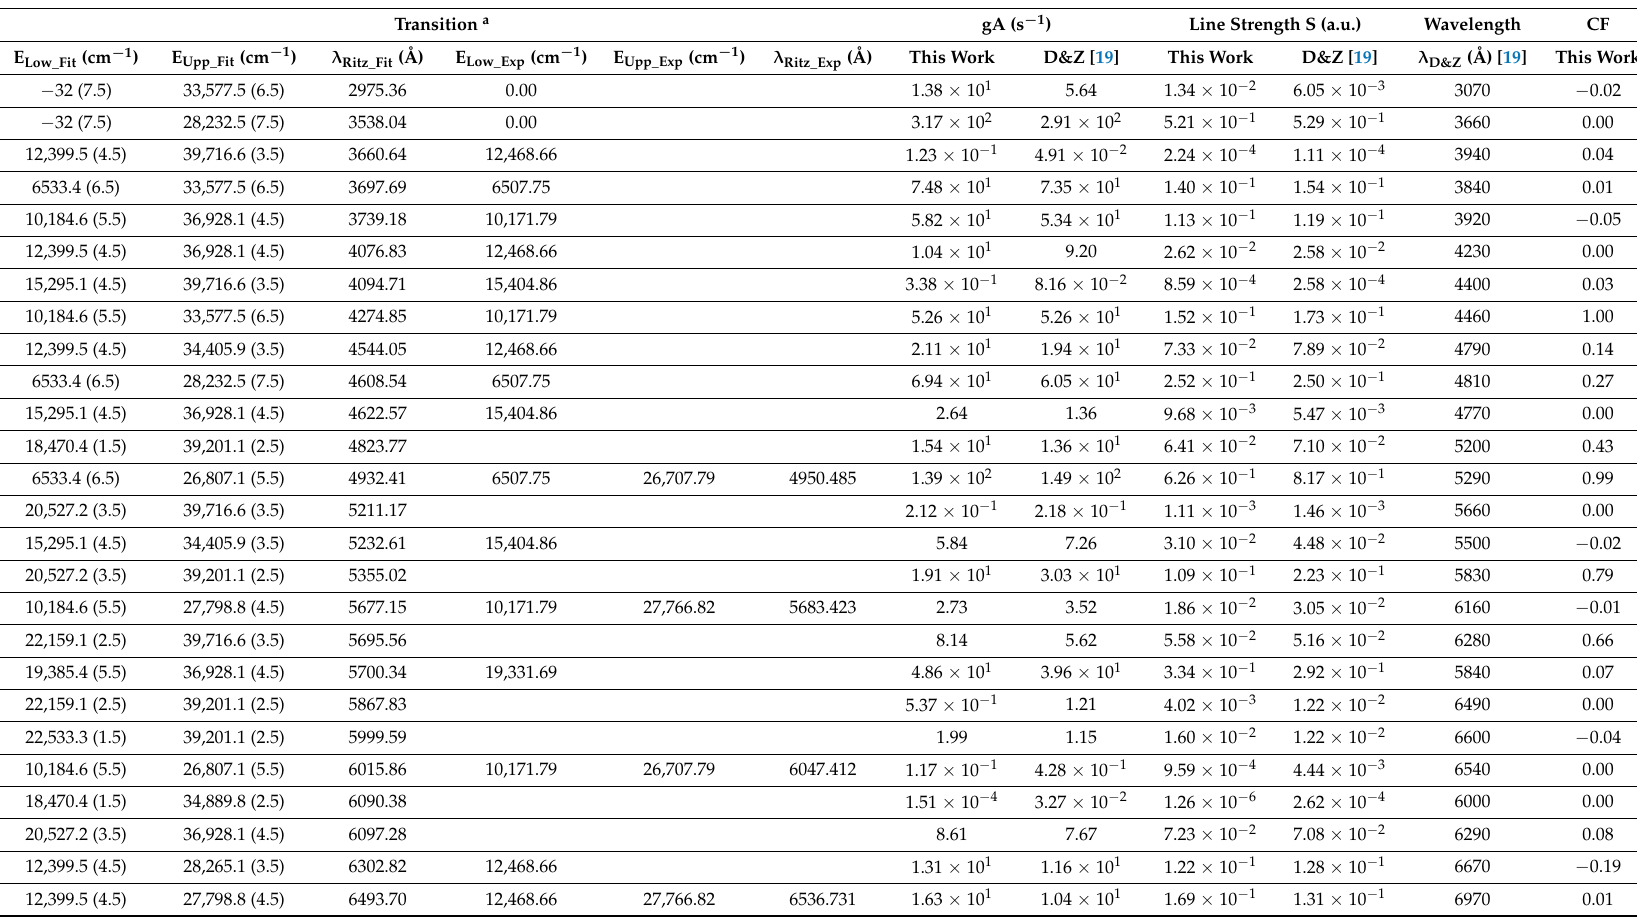
Table 4. Semi-empirical transition probabilities gA (s − 1 ) and line strengths for magnetic dipole (M1) transitions within the Er IV ground-state configuration 4f 11 . Comparison with ab initio results from Dodson and Zia [19]. All wavelengths are in vacuum. Each energy level is specified by its energy value, followed by the quantum number J between parentheses [14]. CF is the cancellation factor as defined by Equation (14.107), p. 432 in [15] and derived from our